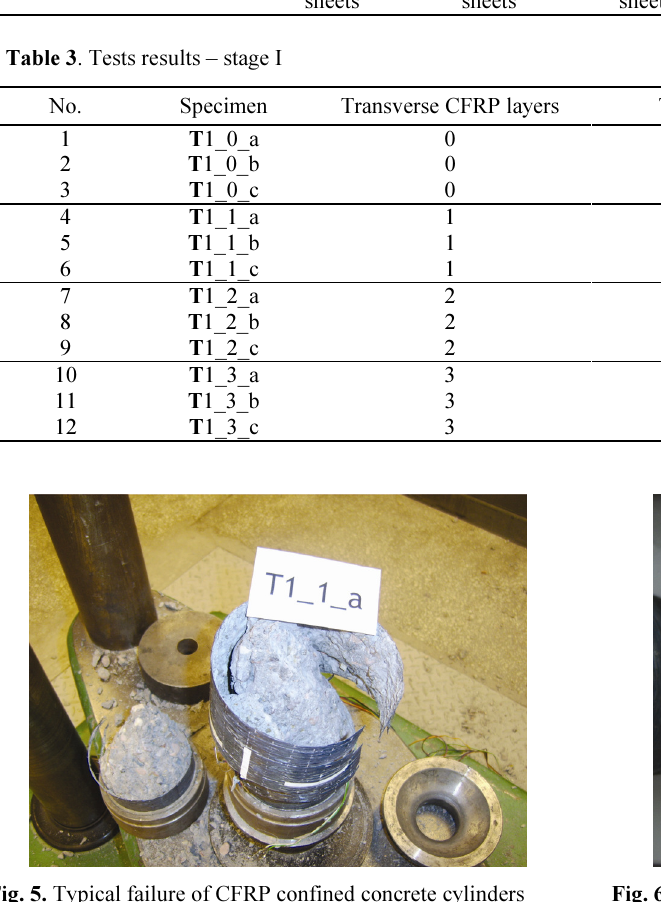
height 3 layers of sheet a three-fold increase of the load-bearing capacity in relation to un-strengthened specimens was found. The limit longitudinal strains increased signifi- cantly from 6‰ by adding one layer of sheet ( T 1_1_a) to 11‰ by adding three layers ( T